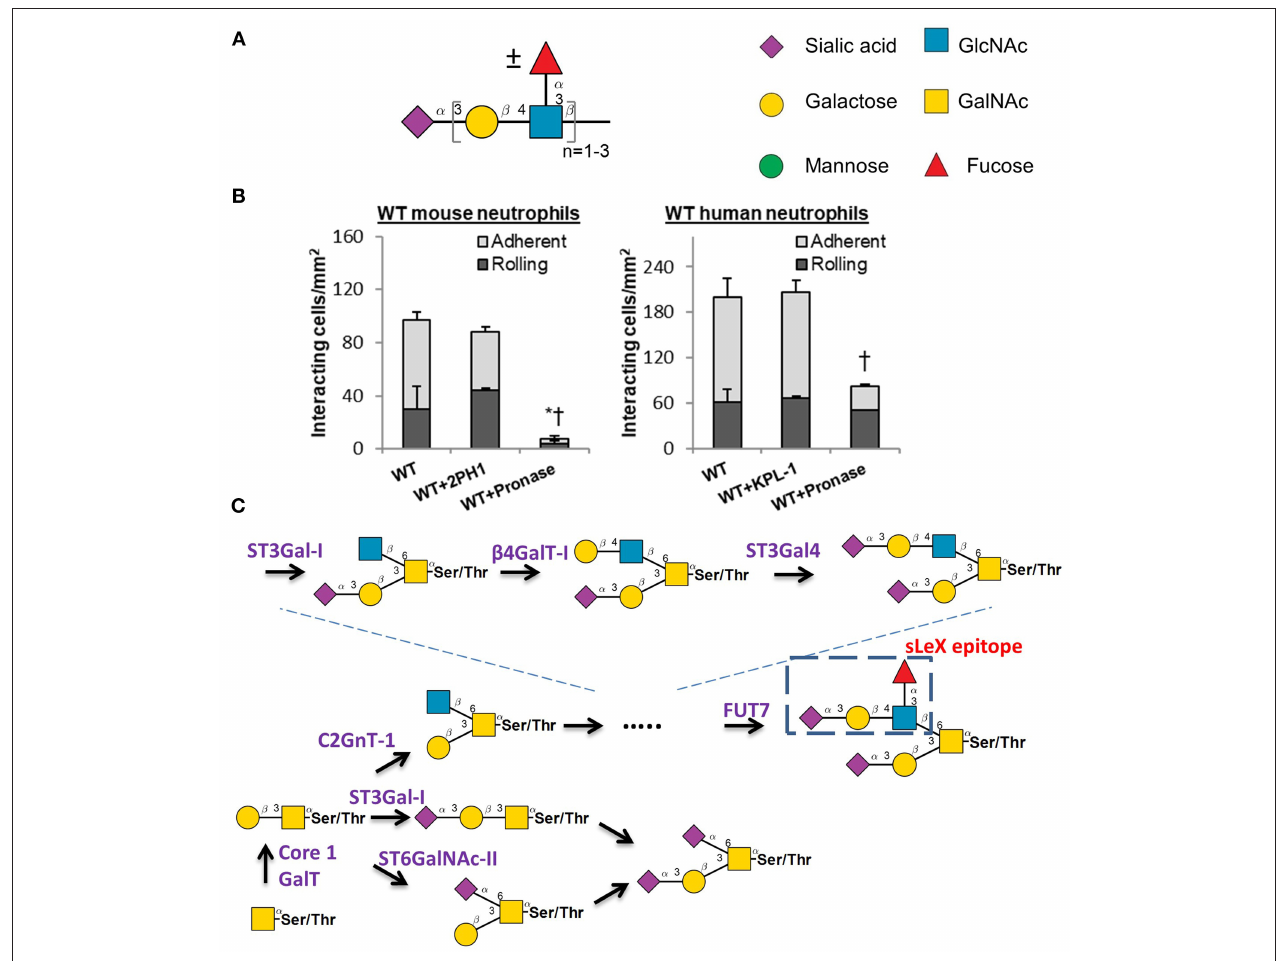
FIGURE 2 | Selectin ligand biosynthesis. (A) Sialofucosylated selectin ligands found on leukocytes are composed of at least one α (2,3) sialic acid and one α (1,3) fucose, typically on a Type-II lactosamine chain that may repeat. (B) Human leukocyte rolling on HUVEC monolayer is resistant to pronase digestion, but this is not the case for mice. * and †: P < 0.05 for rolling and adherent cells, respectively. (C) Selectin ligand biosynthesis at the N-terminus of PSGL-1. Competing pathways regulate the biosynthesis of the sialyl Lewis-X (sLe x ) epitope on core-2 based O-glycans. These competing enzymes are the core2 GlcNAc-transferase, ST3GaI-I, and ST6GaINAc enzymes. (B) is adapted from Mondal et al. (58) with